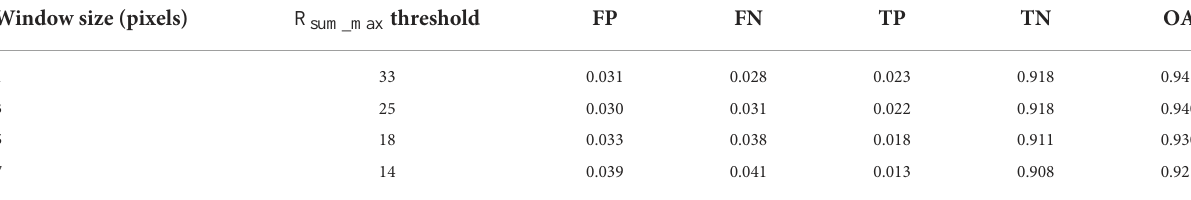
TABLE 3 Comparison between the CuSum algorithm and the UAV LiDAR reference map in the study area in Gabon, when boxcar filters of increasing window sizes are applied. Window size